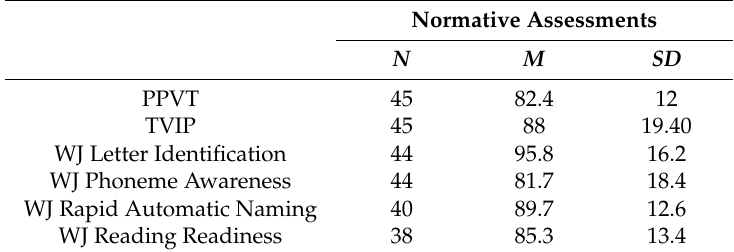
Table 1. Child Performance on Standard Tests—Peabody Picture Vocabulary Test, Test de Vocabulario en Im á genes Peabody (TVIP) and Woodcock Johnson (WJ) ( N =